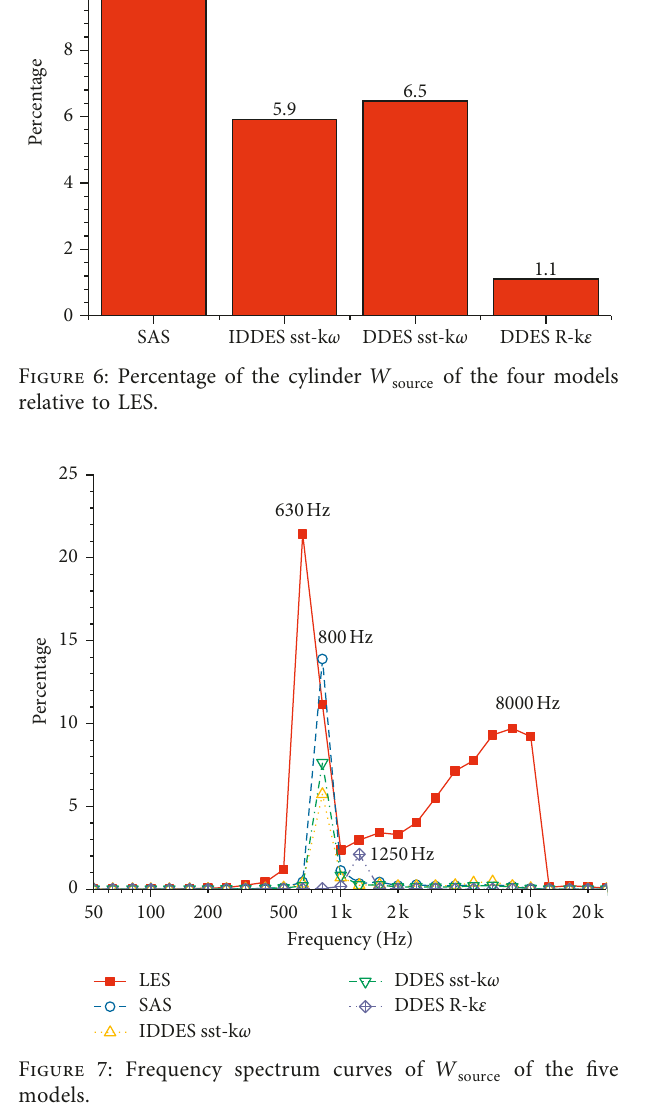
of the five source